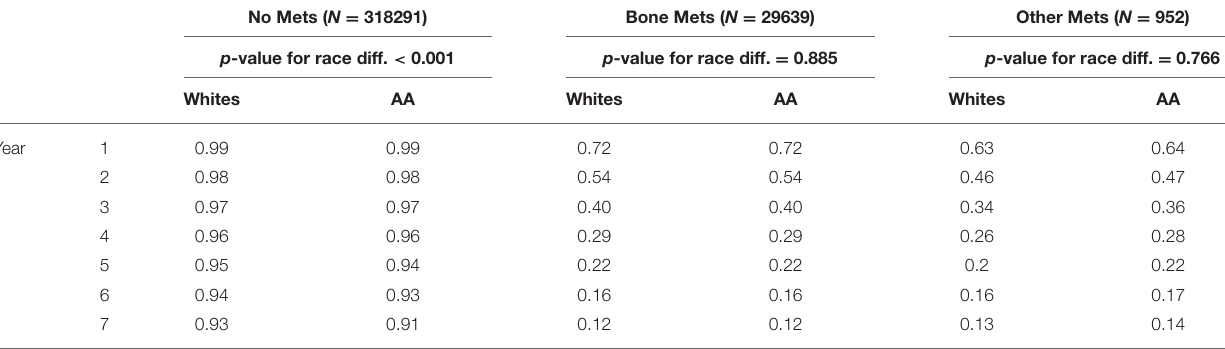
TABLE 2 | Predicted probabilities of yearly survival by metastasis type (AA: African Americans). No Mets ( N = 318291) Bone Mets ( N = 29639) Other Mets ( N = 952) p -value for race diff. < 0.001 p -value for race diff. = 0.885 p -value for race diff. = 0.766 Whites AA Whites AA Whites AA